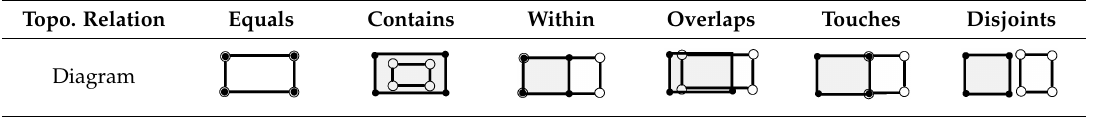
Table 1. The topology relations of geospatial polygons (adapted from [40]). Topo. Relation